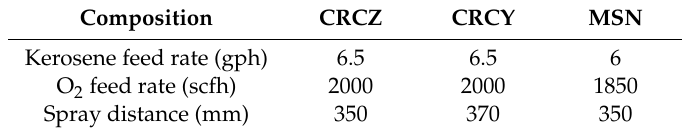
Table 2. Deposition parameters of high velocity oxy-fuel (HVOF) thermal-sprayed coatings.